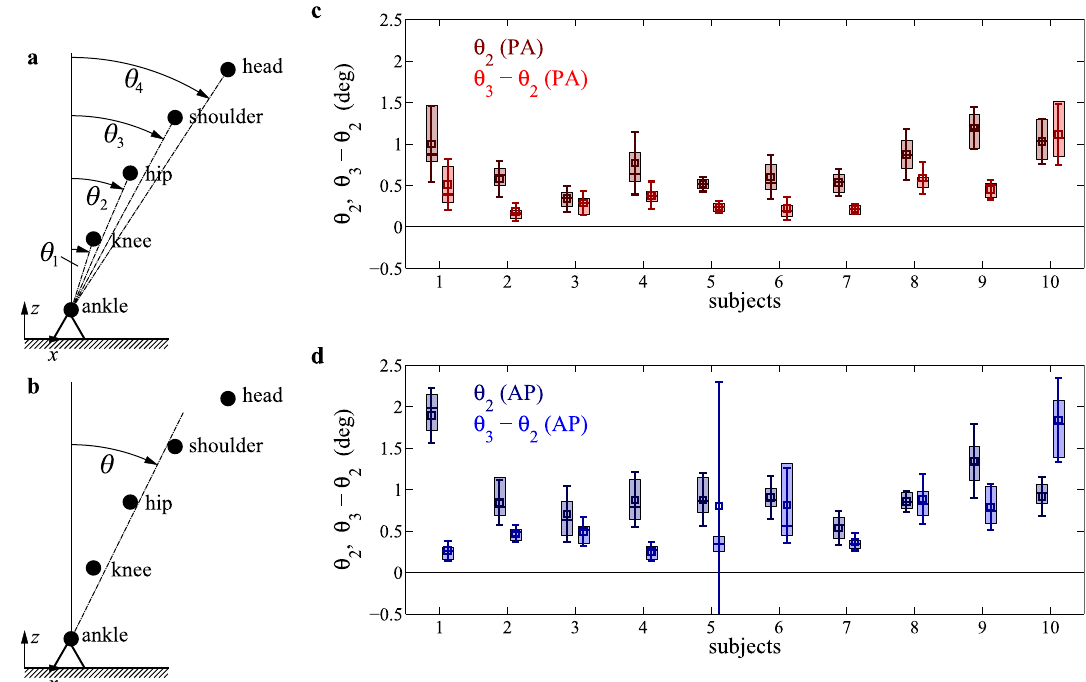
Figure 6. Measured tilt angles. ( a ) Absolute tilt angles: ankle–knee ( θ 1 ), ankle–hip ( θ 2 ), ankle–shoulder ( θ 3 ) and ankle–head ( θ 4 ) angles. ( b ) Average tilt angle of the body used for the single inverted pendulum model. ( c,d ) Average and variations of the RMS values of the angles across the ankle ( ∼ θ 2 ) and the hip ( ∼ θ 3 − θ 2 ) for the individual trials per subjects for PA ( c ) and AP ( d )